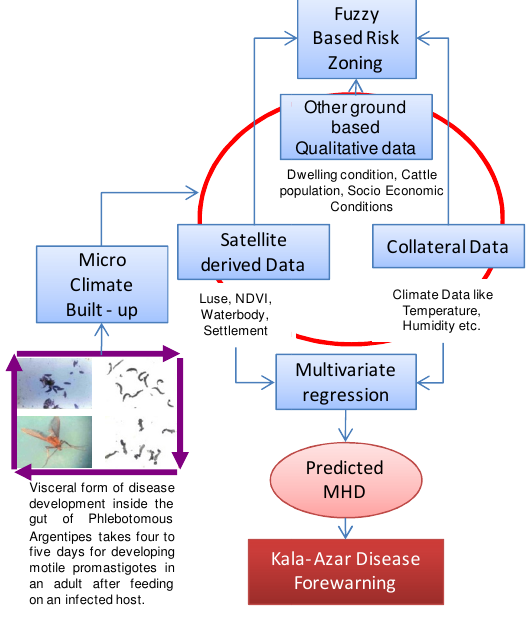
Visceral form of disease development inside the gut of Phlebotomous Argentipes takes four to five days for developing motile promastigotes in an adult after feeding onan infectedhost.